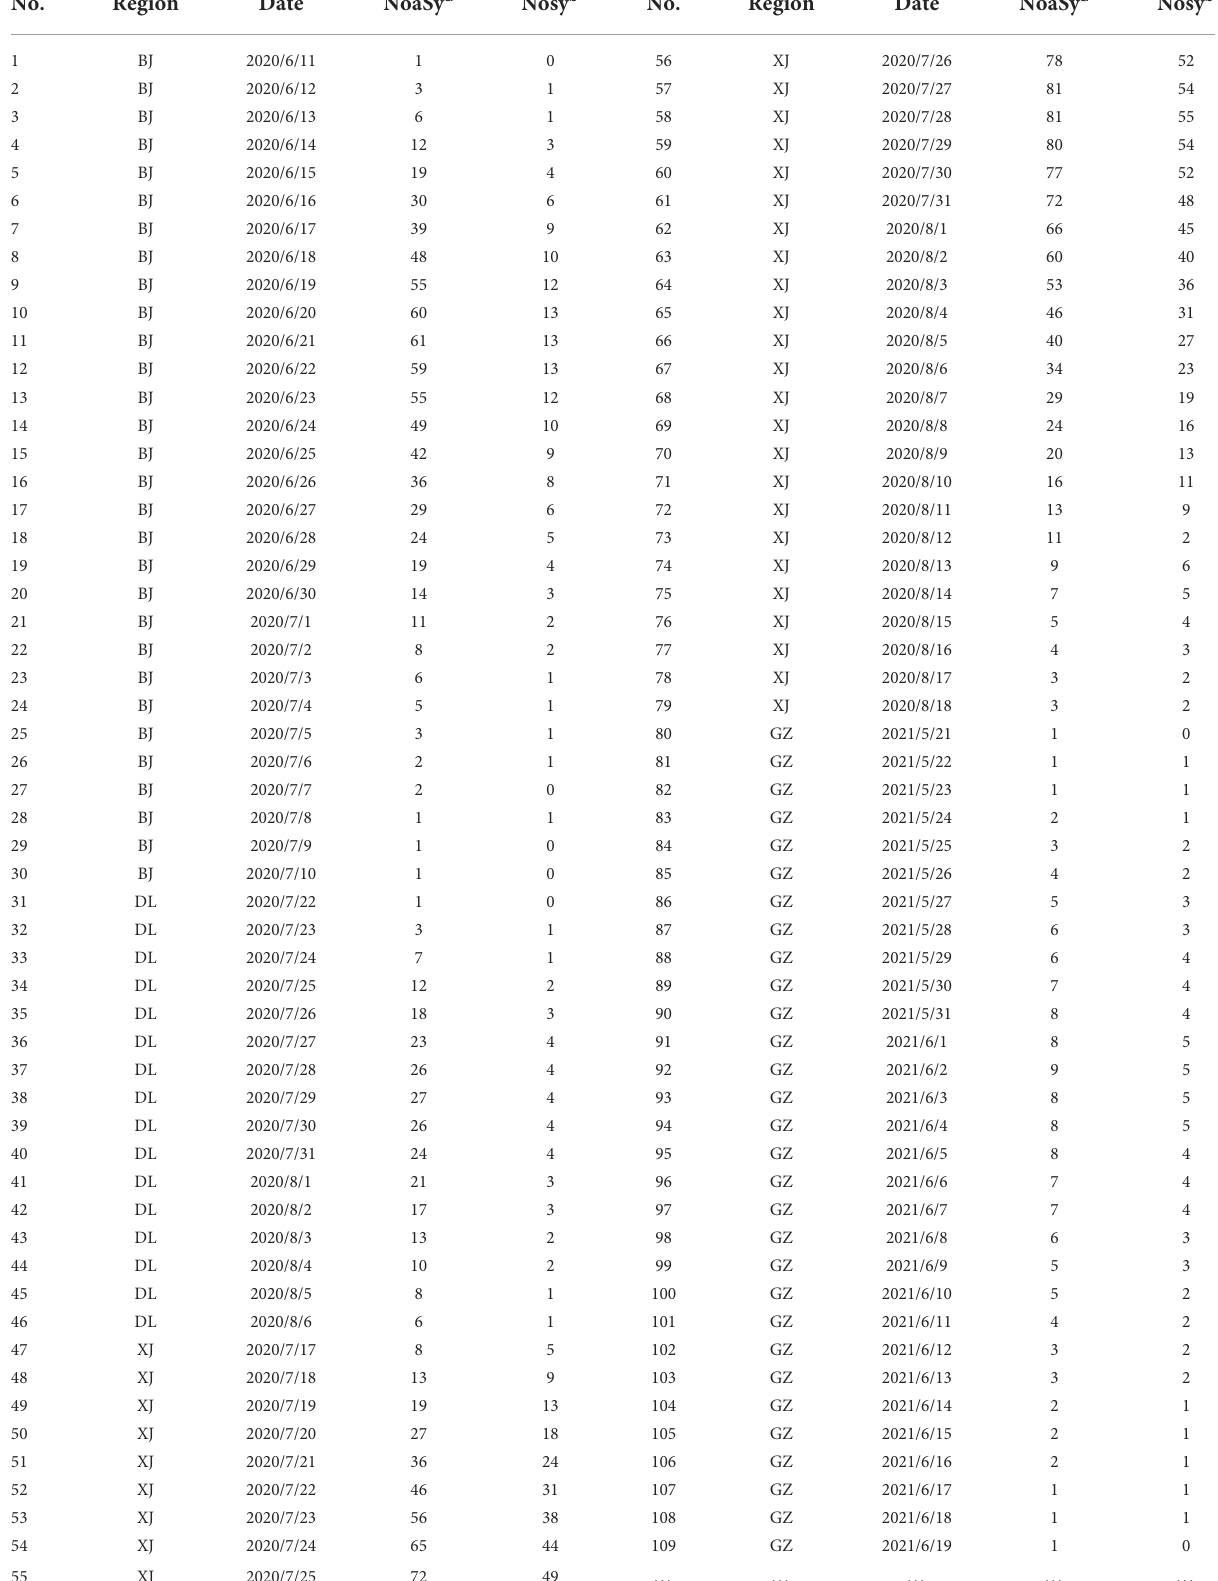
TABLE 5 The number of daily infections caused by asymptomatic and symptomatic infections.